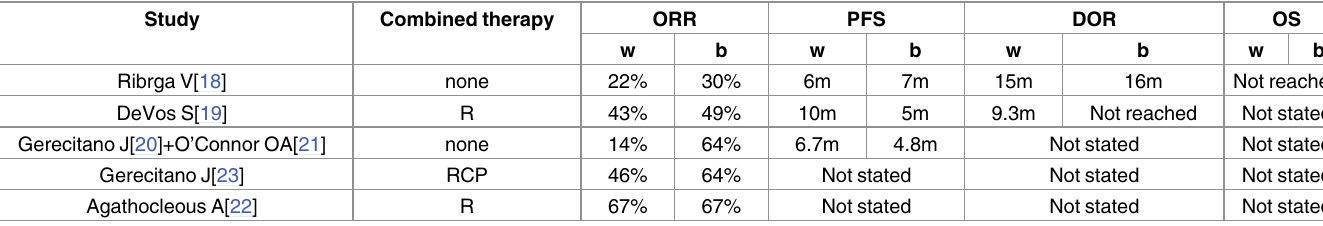
Table 2. Combined therapy and outcomes of studies included in the